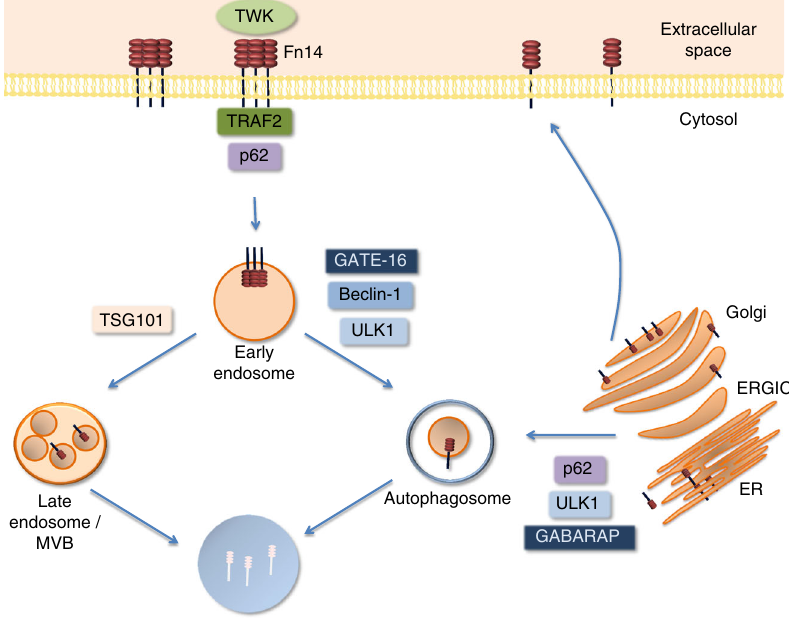
Fig. 7 Regulation of Fn14 by the autophagic machinery. GABARAP-mediated autophagy is responsible for the main pool of the cellular Fn14 and in its absence the receptor accumulates in ERGIC. GATE-16-mediated autophagy and the canonical MVB pathway are responsible in parallel for degradation of Fn14 in endocytic compartments. In absence of GATE-16, Fn14-positive endosomes accumulate at the vicinity of open phagophores. Recruitment of Fn14 to either GABARAP- or GATE-16-dependent autophagosomes is mediated by the cargo receptor p62. Recruitment of internalized Fn14 through the GATE-16- dependent pathway requires TRAF2. The mechanism responsible for recruitment Fn14 to GABARAP-dependent autophagy is still